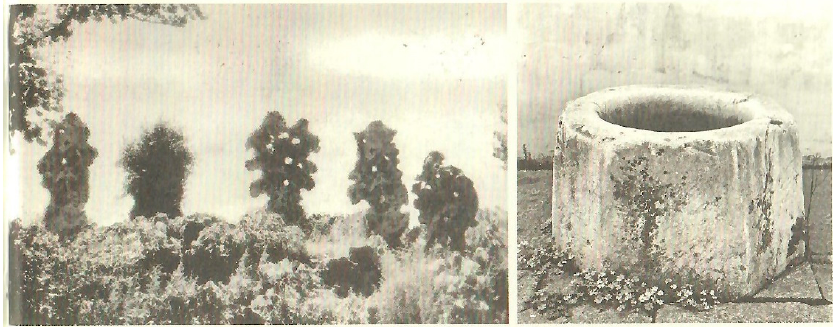
Figure 9. Photos of the five rocks and the ancient well in the Garden of Five Rocks